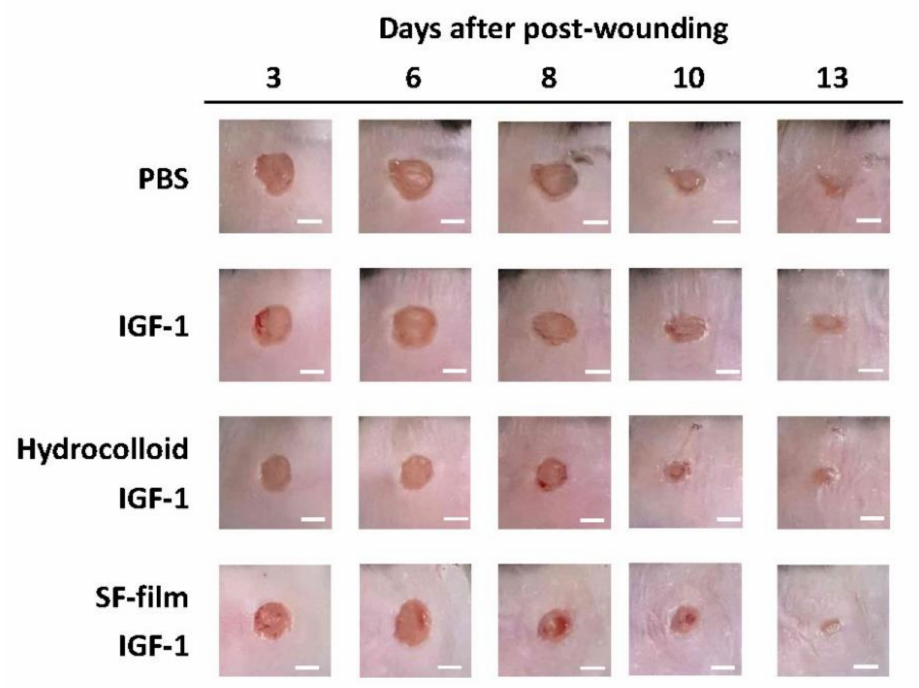
Figure 4. Time course analysis of diabetic wound healing in PBS (control), native insulin-like growth factor 1 (IGF-1), a commercial dressing product (hydrocolloid IGF-1), and insulin-like growth factor 1-loaded silk fibroin film (SF film IGF-1) treatments. Images of the wound area from days 0 to 13 post-wounding (Scale bars = 5